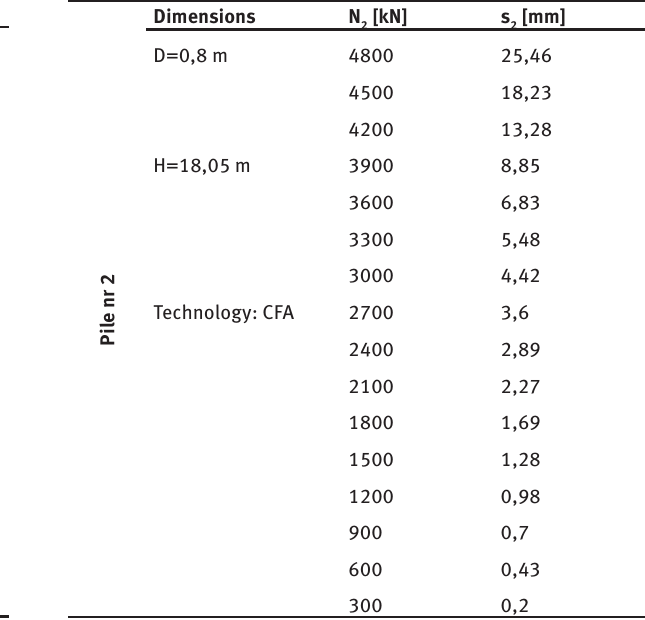
Table 1: Static load test values for Pile 1. Table 2: Static load test values for